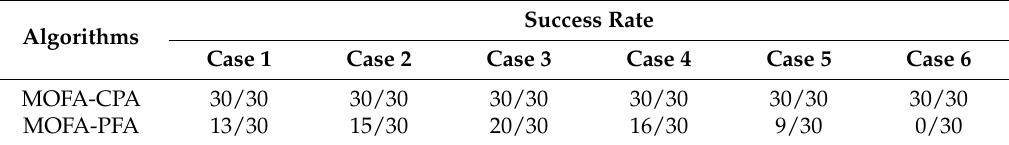
Figure 7. The number of solutions with satisfied constraints in all cases with population size of 100. Table 9. Comparison of the success rate of the two algorithms for Cases